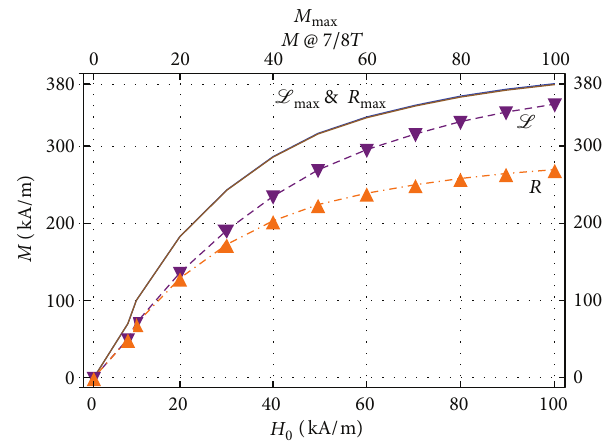
Figure 3: (colour online) The dependence of 𝐴 ∝ 𝐸 , the energy loss, on 𝜔𝜏 for various 𝜔 𝐿 /𝜔 ratios from 0 to 4 . See